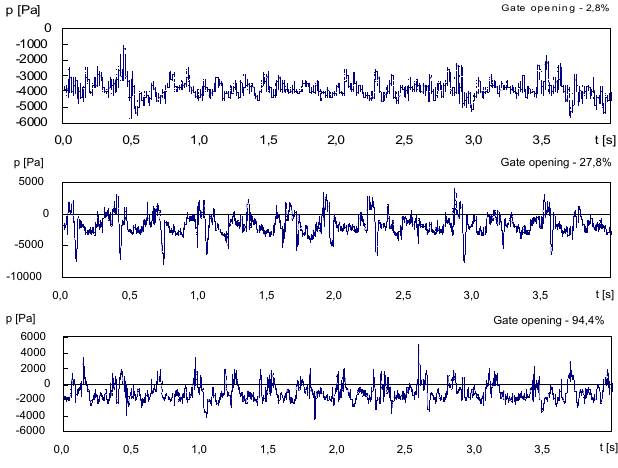
Fig. 6. Time history records of the flow pressures at different gate openings.